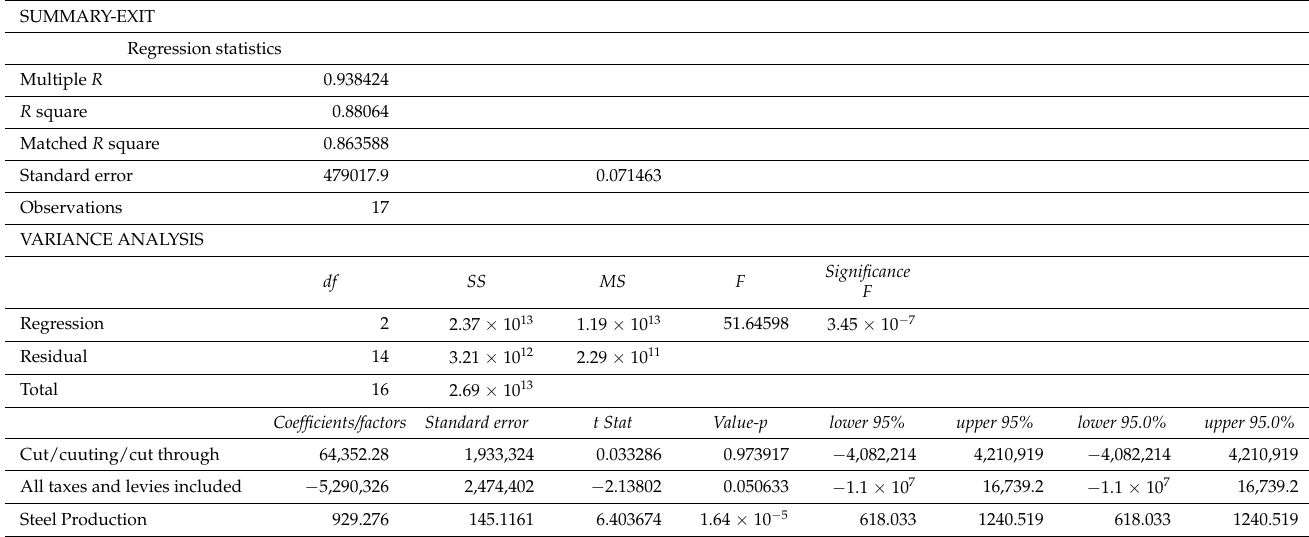
Table 5. The econometric estimation and verification of the analysed